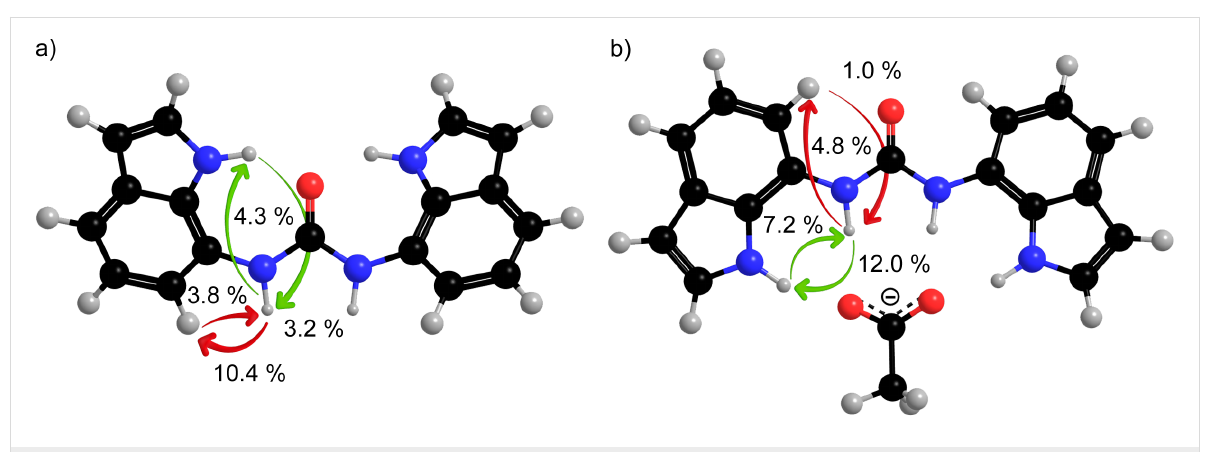
Figure 4: NOE enhancements of 1 in the absence of anions (a) and upon addition of one equivalent of acetate anions